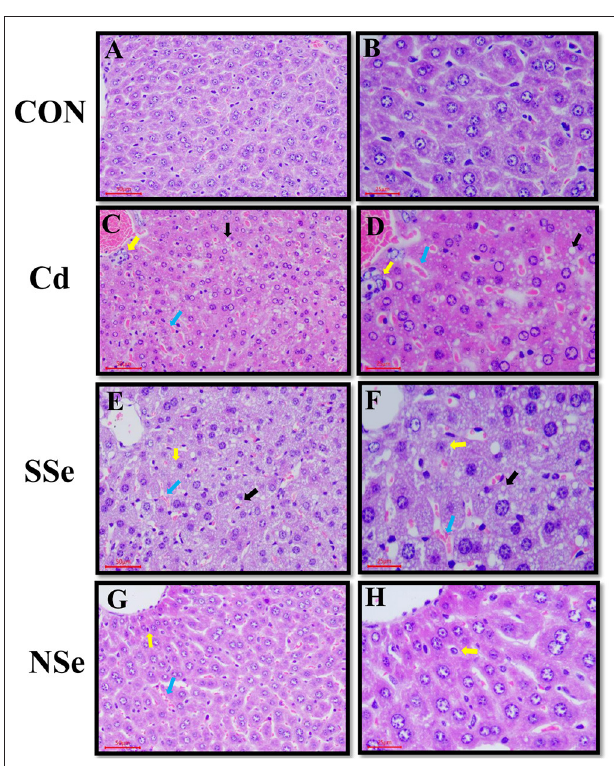
FIGURE 5 | Hepatic morphology, the left magnification:50 µ m, 200X; the right magnification:25 µ m, 400X. Yellow arrows: necrotic hepatocytes; black arrows: fatty degeneration; bule arrows: red blood cells. (A,B) Represent changes in the liver of control group. (C,D) Represent changes in the liver of cadmium group. (E,F) Represent changes in the liver of sodium-selenite group. (G,H) Represent changes in the liver of nano-selenium